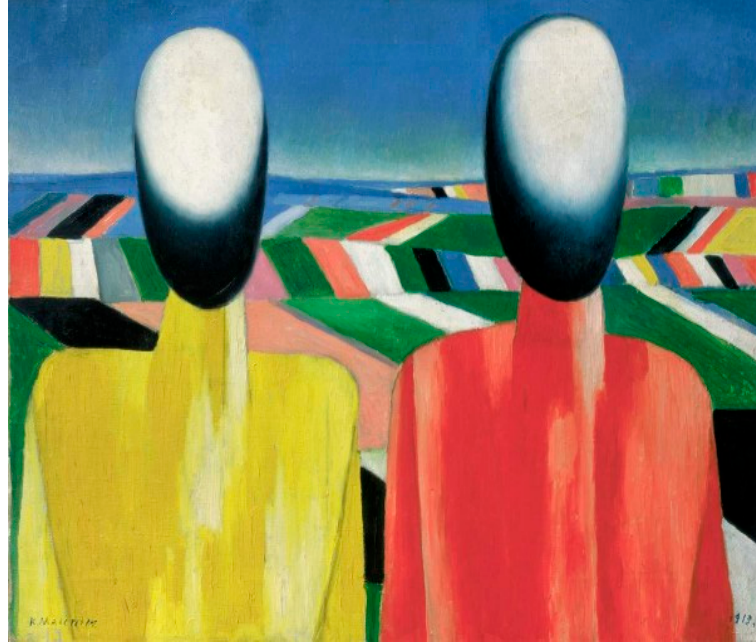
Figure 2. Kazimir Malevich. Two peasants.